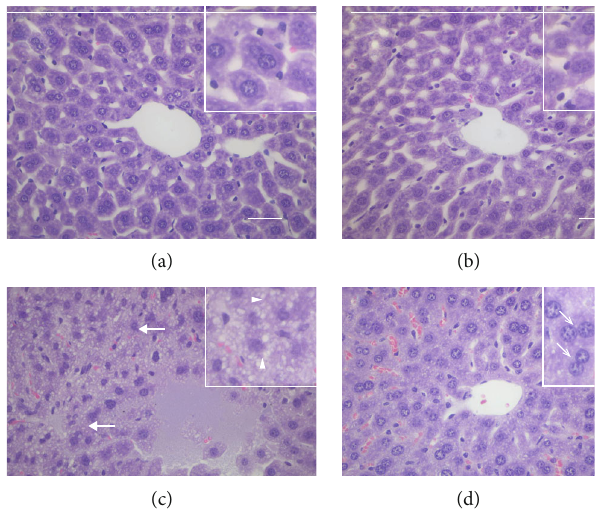
Figure 3: Representative histology photomicrographs of mice liver stained with hematoxylin and eosin. Sham (a), sham + simvastatin (b), CLP (c), and CLP+ simvastatin (d). Intense vacuolization of the centrilobular region (thick arrow), hepatocytes vacuolization (arrowhead, insert), and hepatocyte showing binucleation (thin arrow, insert). Bar 100 μ